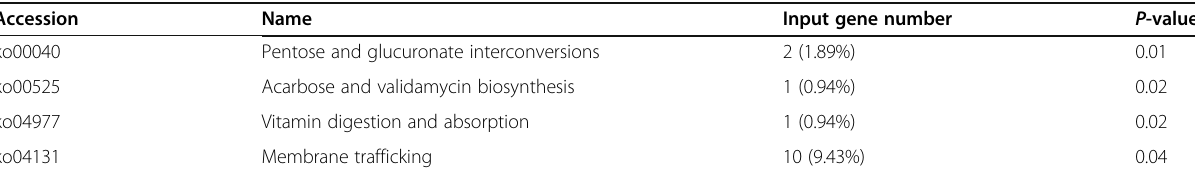
Table 2 KEGG analysis of candidate genes